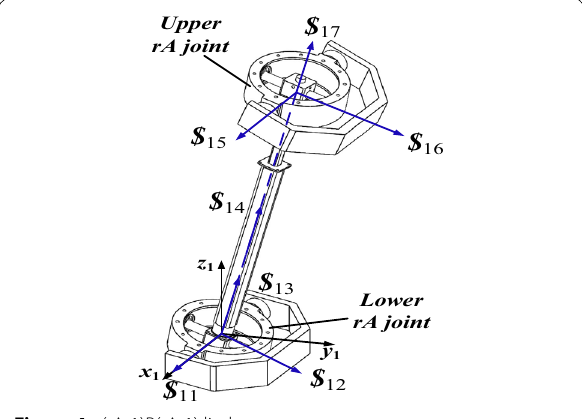
Figure 4. (rA-1)P(rA-1)